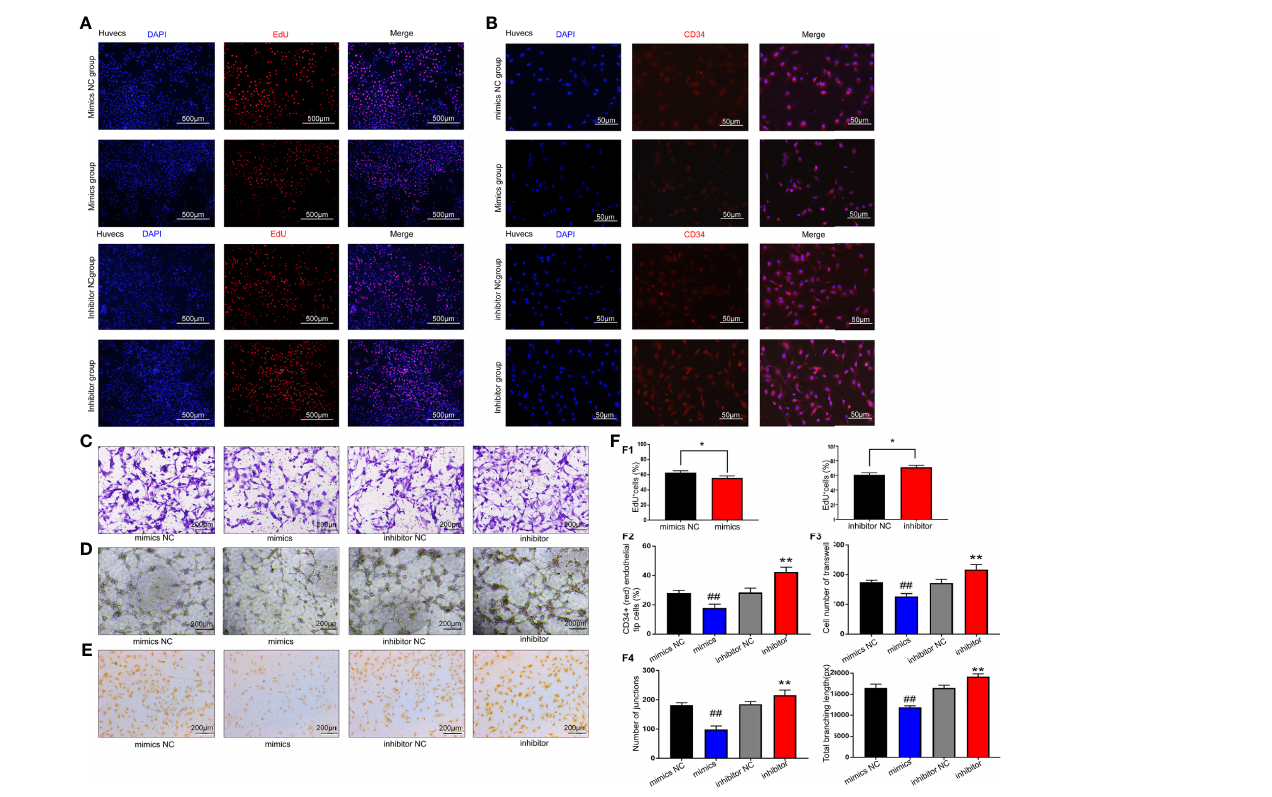
FIGURE 5 | Results of miR-199a-5p functional experiments. (A) EdU results showed that cell proliferation was decreased after HUVEC transfection with miR-199a-5p-mimics compared with the control group. The proliferation ability of HUVECs was improved after transfection with miR-199a-5p inhibitor. (B) Immuno fl uorescence analysis of CD34+ (red) endothelial tip cells after HUVECs were transfected with miR-199a-5p-mimics or inhibitor. Nuclei were stained with DAPI (blue). (C) Transwell experiment results of each group of cells. (D) Tube formation experiment results of each group of cells. (E) CD31 immunohistochemistry experiment results of each group of cells. (F) Experimental quantitative data. F1, Quantitative data of the EdU experiment. The percentage of EdU ‐ positive cells for each group was quantitated using ImageJ software. F2, Quantitative CD34 immuno fl uorescence experiment data. F3, Quantitative data of cell Transwell experiments. F4, Quantitative data of the tube formation ability of each group of cells. * represents a statistically-signi fi cant difference compared with the control group (P < 0.05). ** represents a statistically signi fi cant difference compared with the inhibitor-NC group (P < 0.01). ## represents a statistically signi fi cant difference compared with the mimic-NC group (P